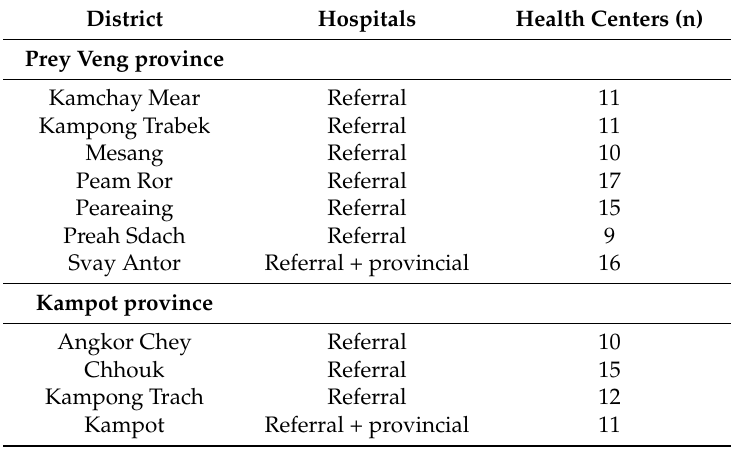
Table 1. Healthcare facilities by district in Prey Veng and Kampot provinces, in 2010. District Hospitals Health Centers